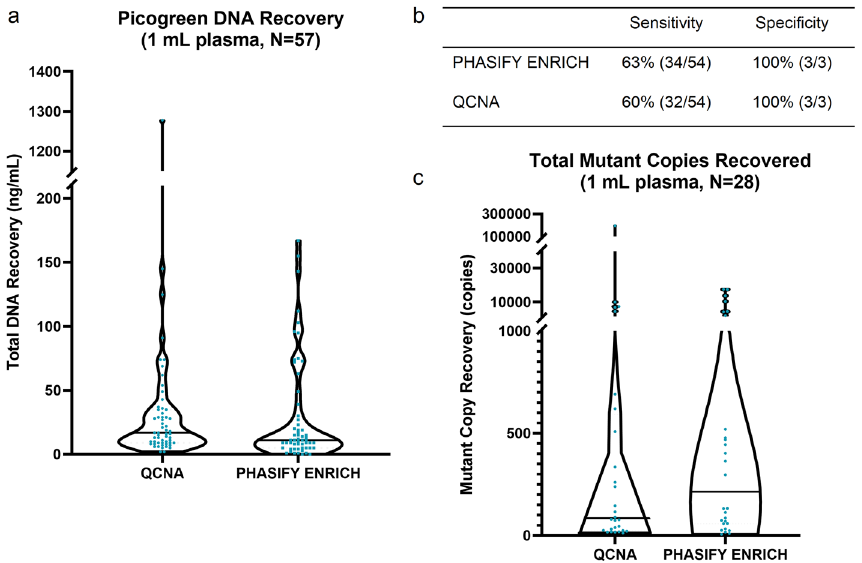
Figure 4. Results of PHASIFY ENRICH against QCNA. ( a ) A violin plot of total DNA recovery from 1 mL of plasma from QCNA and PHASIFY ENRICH. Median bars are shown as solid black lines. Median DNA recovery for QCNA and PHASIFY ENRICH are 17 ng and 11 ng, respectively (35% decrease). ( b ) Sensitivity and specificity values of PHASIFY ENRICH and QCNA against tissue genotyping. ( c ) A violin plot of total mutant copies recovered from QCNA and PHASIFY ENRICH out of the samples in which both kits detected mutations (n = 28). Median bars are shown as solid black lines. Median mutant copy recovery for QCNA and PHASIFY ENRICH are 85 copies and 215 copies, respectively (153%